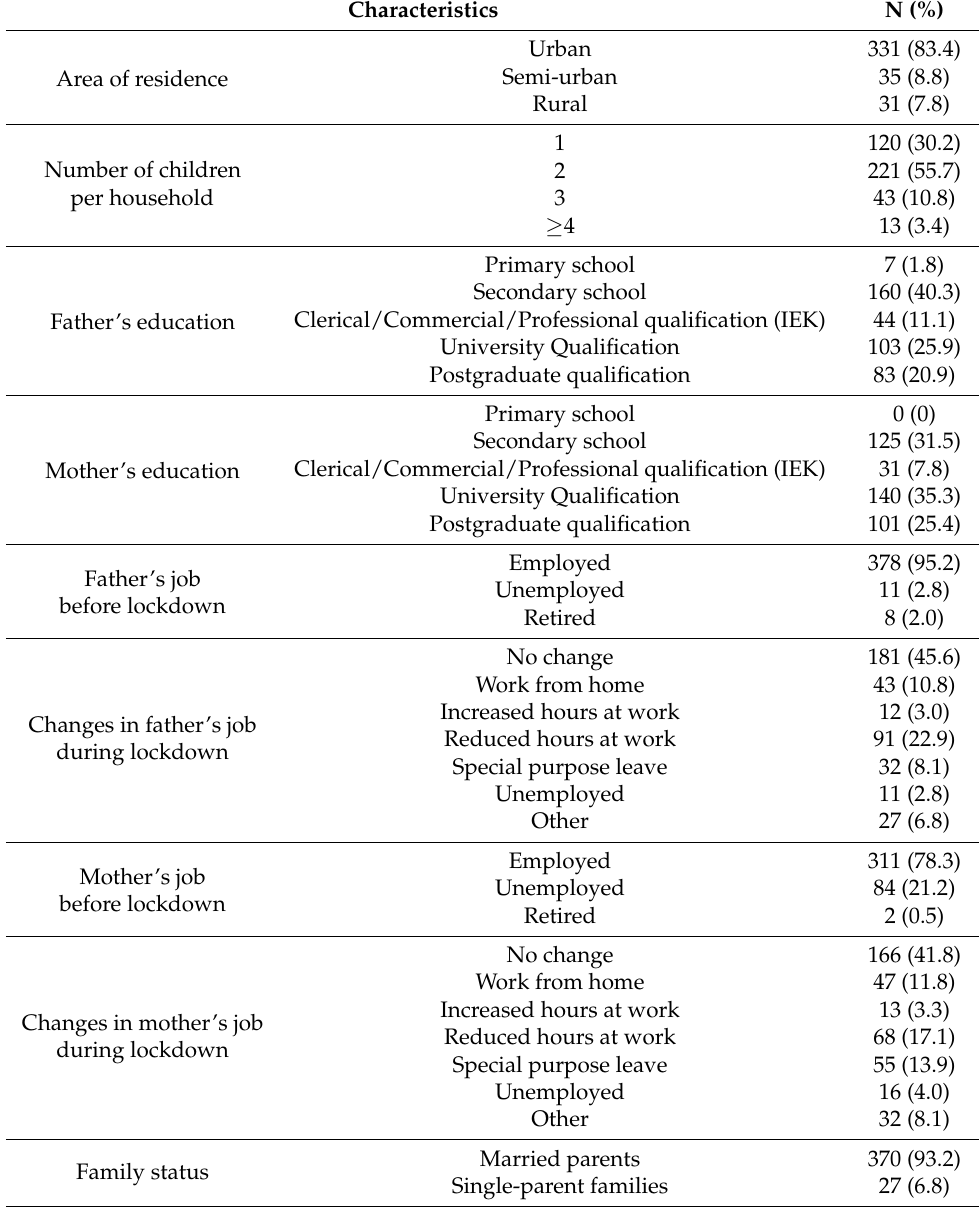
Table 2. Sociodemographic characteristics of the